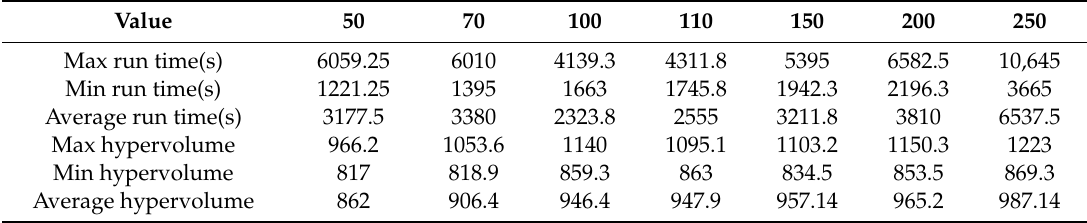
Table 5. Run time and hypervolume under different iteration numbers.